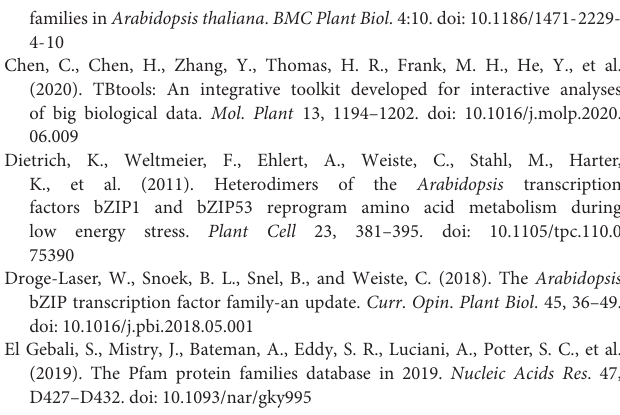
Supplementary Table 1 | The qRT-PCR primers used in this study. Supplementary Table 2 | The detail information of identified potato bZIP family members. Supplementary Table 3 | The syntenic pairs between potato and other four plant species. Supplementary Table 4 | The putative conserved motifs in StbZIP proteins. Supplementary Table 5 | The detail information of segmental and tandem duplication gene pairs. Supplementary Table 6 | Regulatory elements in the promoter regions of StbZIP genes. Supplementary Table 7 | The detail information of the induced StbZIP gene under various stress